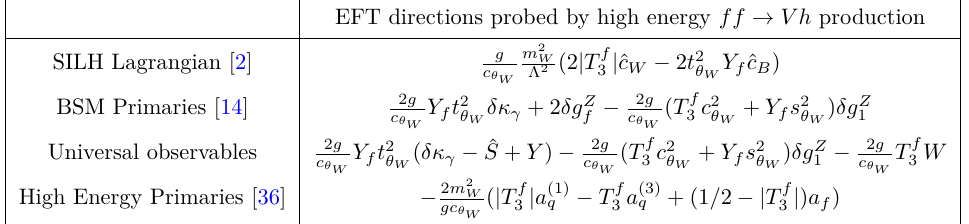
Table 2 . The contact interaction couplings g h EFT parametrisation. For a given f the expression can be read off from this table by substituting the corresponding value of the SU (2) L and U (1) Y quantum numbers T f c W + c HW − c 2 W and ˆ c B = c B + c HB − c 2 B